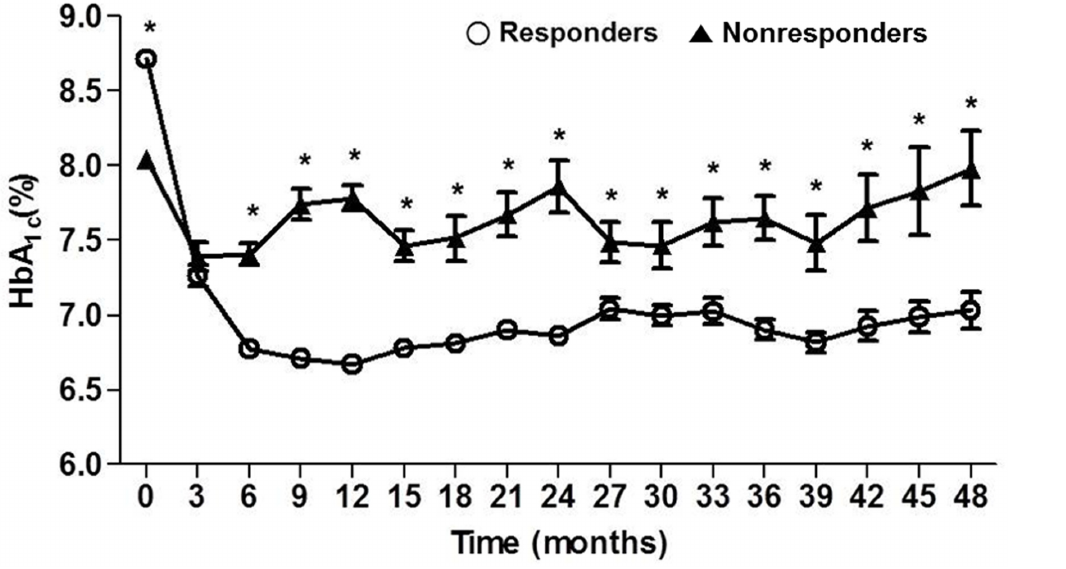
Fig 2. Comparison of HbA 1c levels for 48 months between responders (n = 315) and nonresponders (n = 42) when response was defined as (cid:1) 0.8% of HbA 1c reduction from baseline or attainment of target HbA 1c ( (cid:3) 7.0%) at the end of 4 years ’ follow-up. * P < 0.001 for responder vs. nonresponder